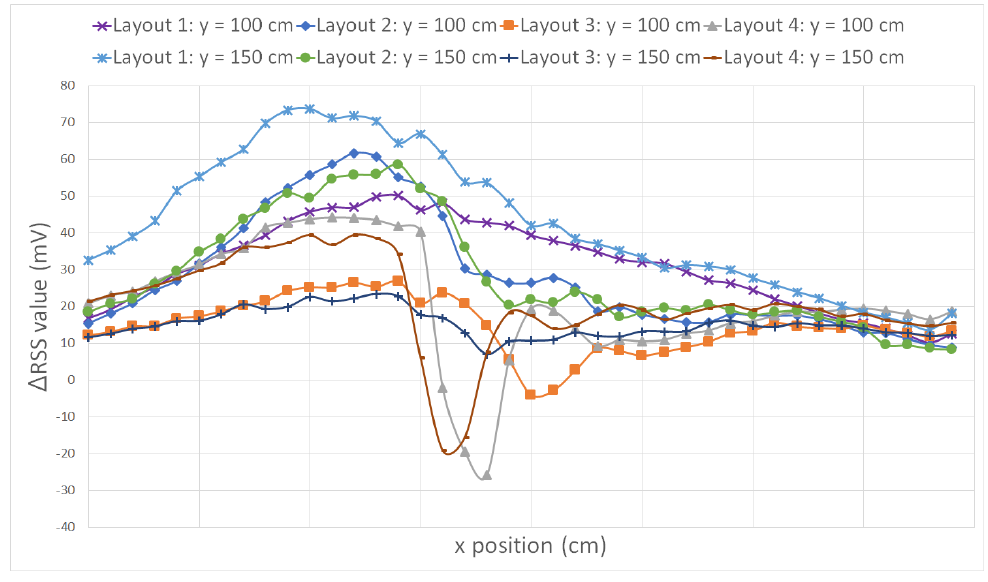
Figure 9. ( a ) RSS lapses of the every layout, ( b ) Visual representation of the layouts and the scenarios.